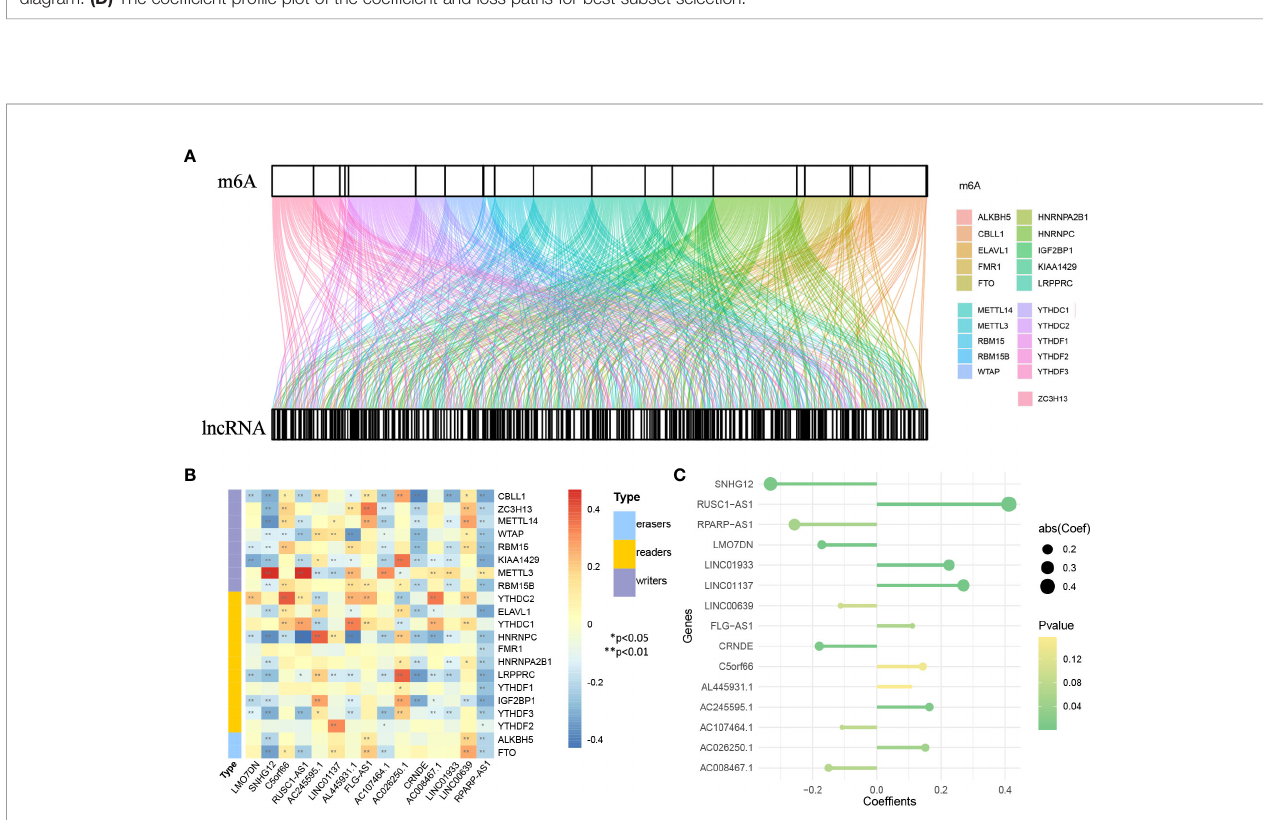
FIGURE 8 | Identi fi cation of genes in lncRNA model. (A) Sankey diagram of 21 m 6 A regulators and 1930 m 6 A-related lncRNAs. (B) The heatmap for the correlation between 21 m 6 A genes and 15 prognostic m 6 A-related lncRNAs. (C) The coef fi cients of 15 lncRNAs in the